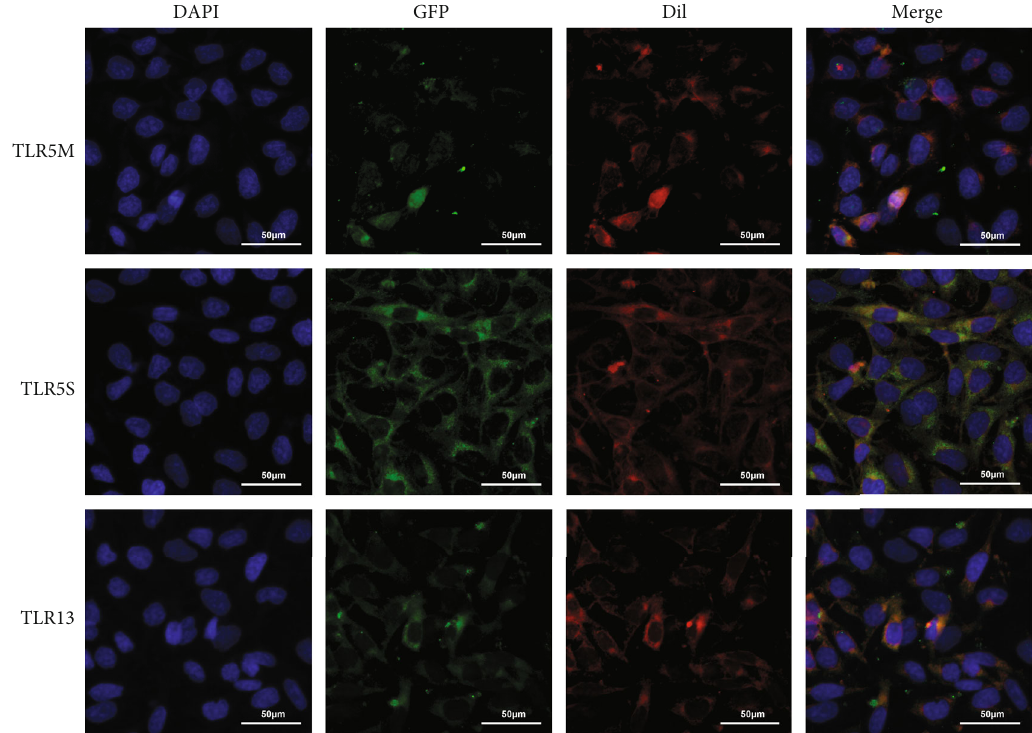
Figure 6: The subcellular localization of TLR5M, TLR5S, and TLR13 in LO2 cells. Panels of the fi rst line were TLR5M, TLR5S, and TLR13 proteins, respectively. The middle panels were the cell nucleus stained with DAPI. Panels of the last line were the merged images of immuno fl uorescenced protein and DAPI, GFP, and